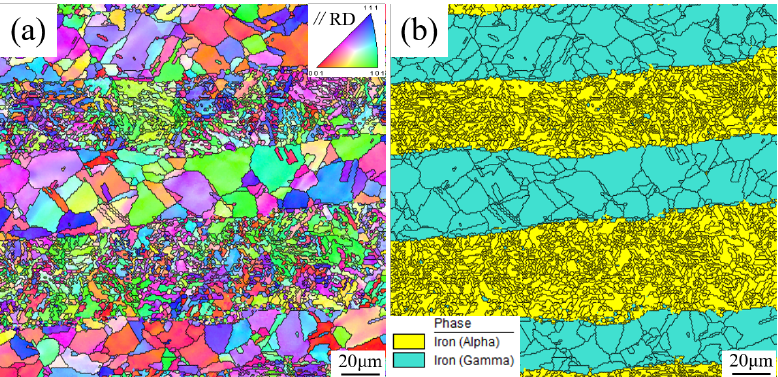
Figure 2. EBSD diagram for the hot-rolled sample: ( a ) Inverse pole figure; ( b ) phase figure and corresponding grain boundaries.